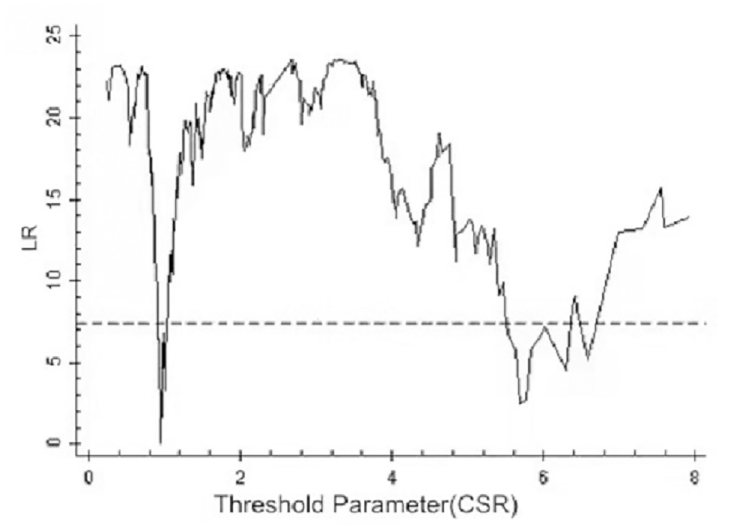
Fig 1. Estimated value and confidence interval of the first threshold in Model 1.